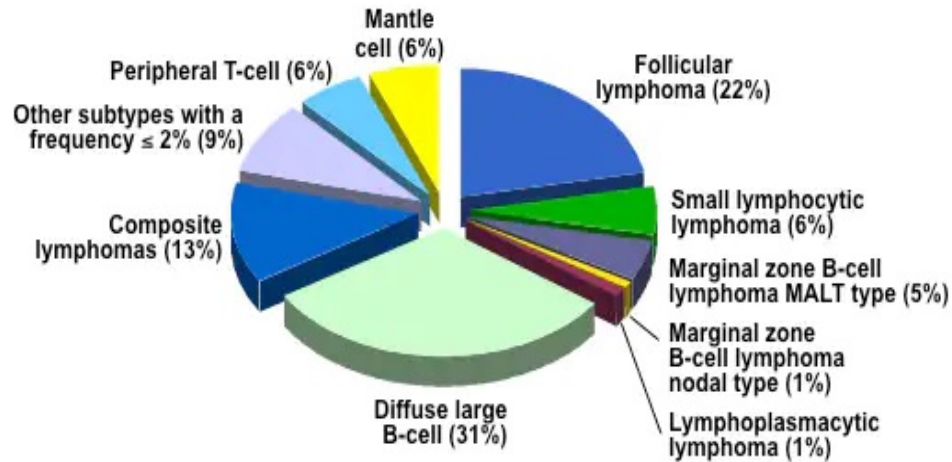
Figure 1. Classification of Non-Hodgkin Lymphoma: A Subtypes (Source: American Cancer Soci-